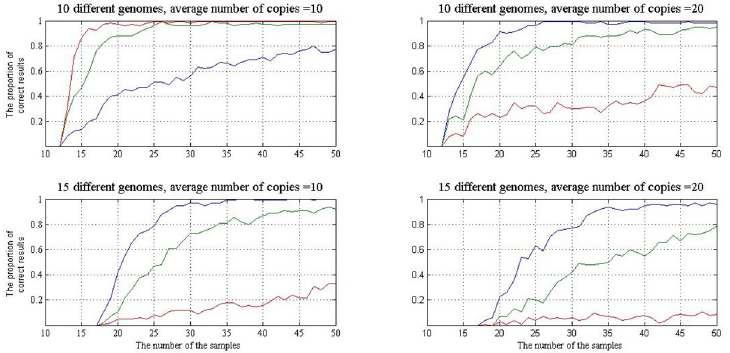
Fig 4. Results of estimating the number of genomes in a metagenome in the course of sequential increase of the number of samples. The BS spectra of genomes were taken from the corresponding fragment sets G (g, 75). In each chart, the lower, middle, and upper curves correspond to σ = 1, 2, 3, respectively. X axis: the number of samples; Y axis: the proportion of correct (the error not more than ± 1) to all